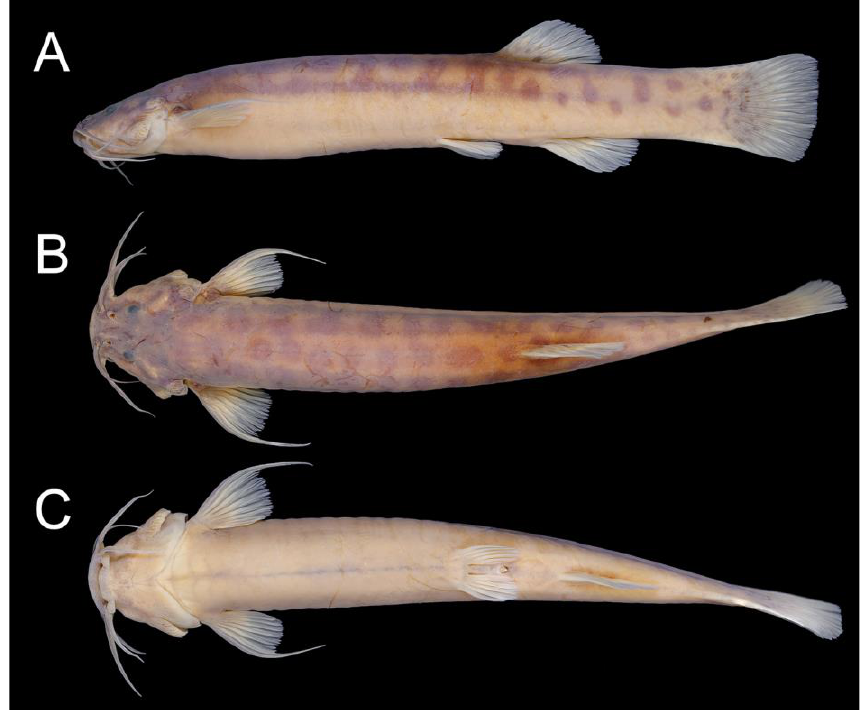
Figure 12. Trichomycterus puriventris , UFRJ 5398, paratype, 76.9 mm SL: ( A ) lateral, ( B ) dorsal, and ( C ) ventral views.